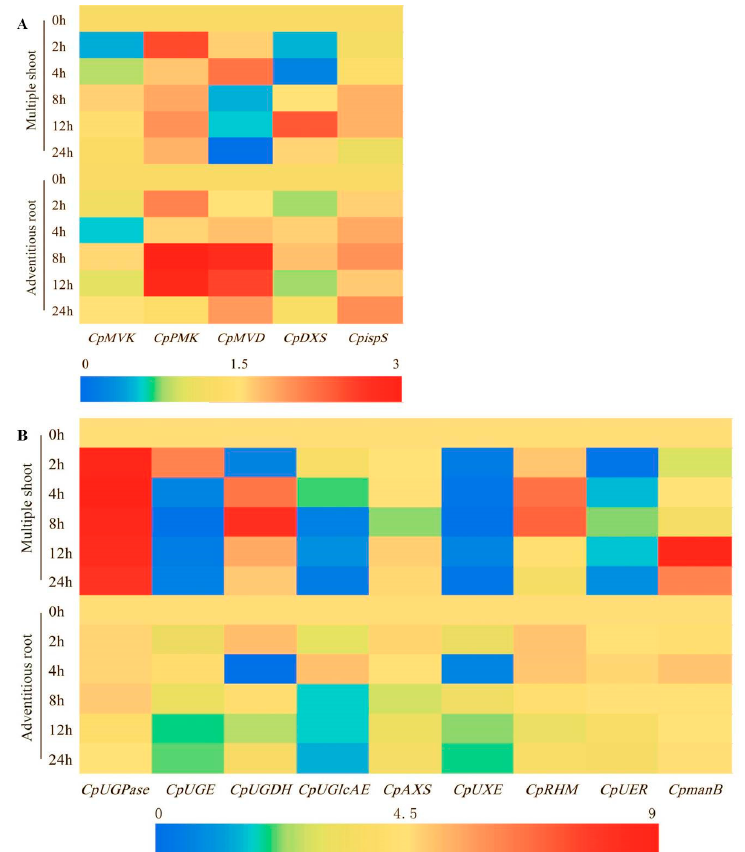
Figure 9. Expression patterns of the genes involved in the biosynthesis of terpenes ( A ), polysaccharides and glycosides ( B ) in C. pilosula adventitious root and multiple shoots with MeJA treatment. CpGAPDH was used as the reference gene. Blue indicated the lowest expression. Red indicated the highest expression.